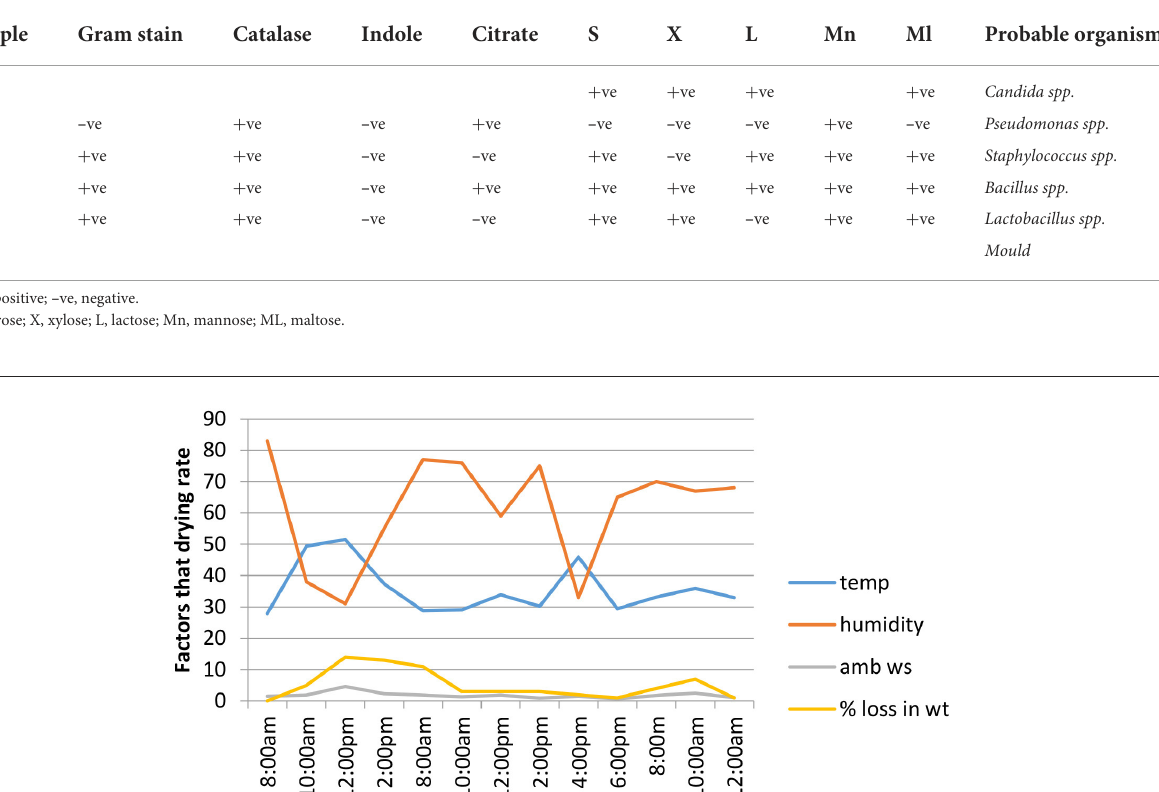
TABLE 1c Results from test with carbohydrates.